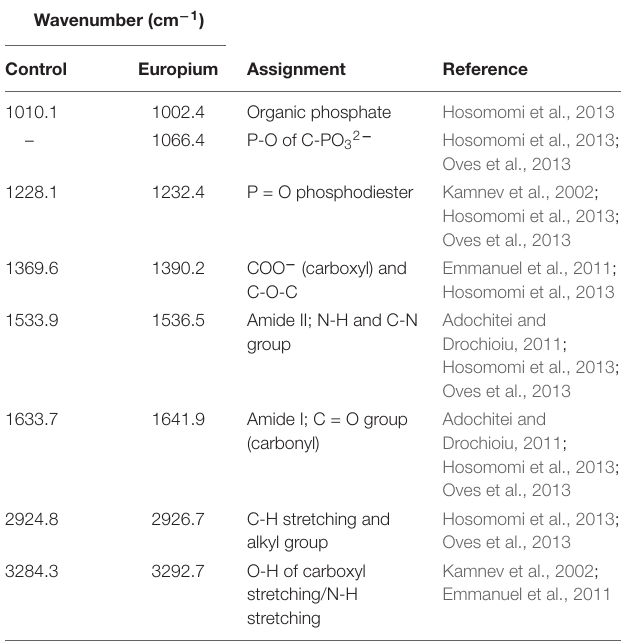
TABLE 2 | Assignment of FTIR derived peaks to functional groups of T. scotoductus